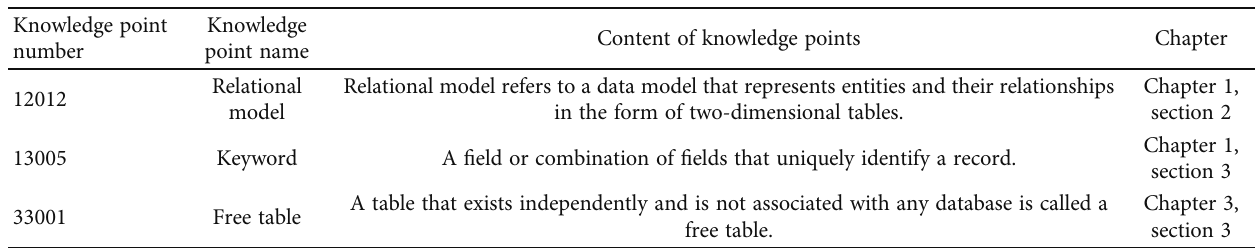
Figure 12: Platform function diagram. Table 4: Examples of knowledge points.